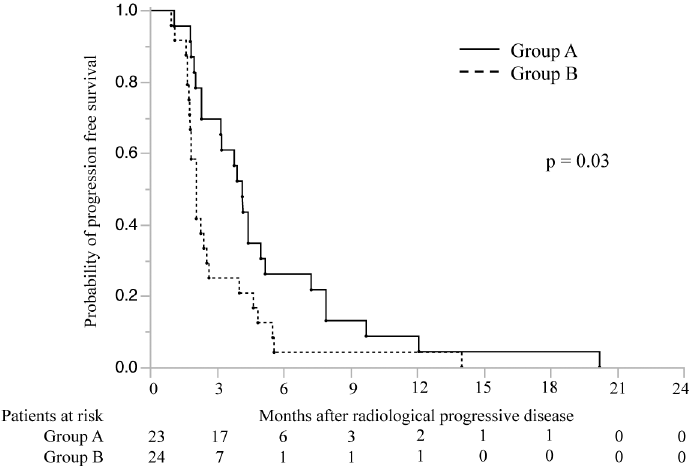
Fig 3. Cumulative progression-free survival rates in patients receiving continuous sorafenib treatment. The graph compares survival rates in patients who received sorafenib (cid:1) 4 months (group A, n = 23) or < 4 months (group B, n = 24) before radiologic confirmation of progressive